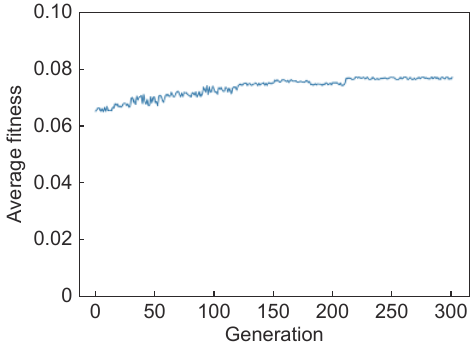
Fig. 3 Average fitness value of the hybrid algorithm in each generation.